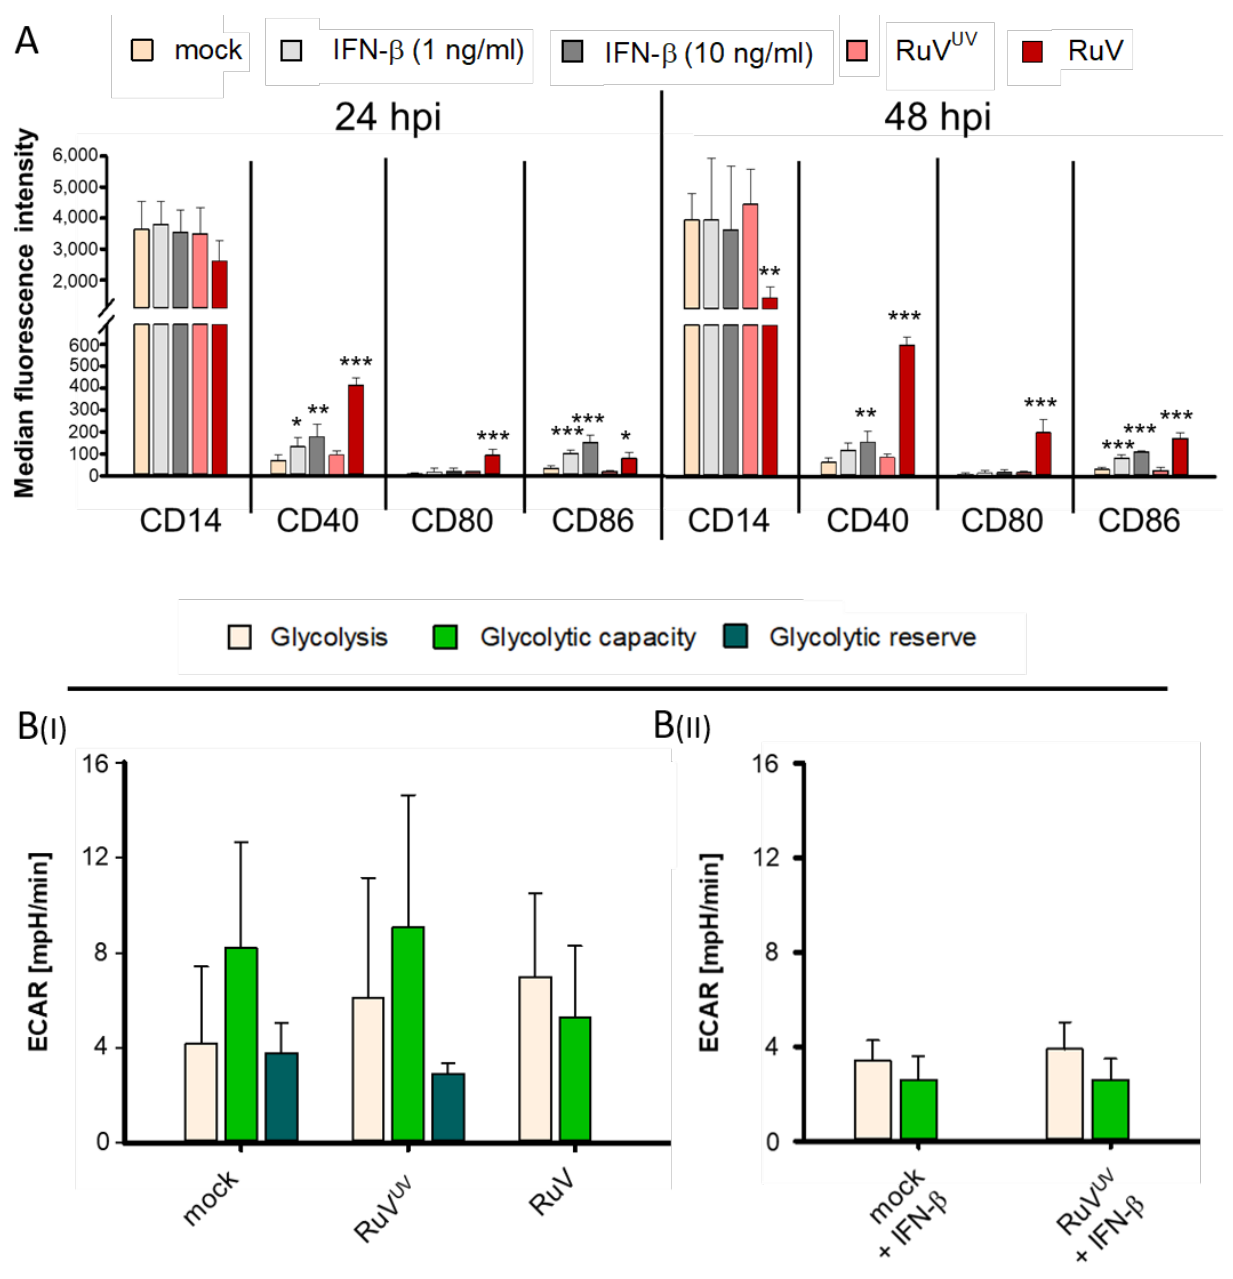
Figure 3. During RuV infection and in the presence of exogenous IFN- β glycolytic reserve was lost in M-M Φ . ( A ) Analysis of surface expression of CD14, CD40, CD80, and CD86 in mock-, RuV UV -, and RuV-infected and exogenous IFN- β treated GM- and M-M Φ by flow cytometry after indicated incubation intervals. Relative surface marker expression after application of exogenous IFN- β (10 ng/mL) for 24 h was assessed by flow cytometry with the respective antibodies. Values ( n = 3) of the isotype-corrected MFI ± SD are shown. Statistical analysis was performed using ANOVA test and significance was calculated to the respective mock control. ( B ) M-M Φ (5 × 10 5 /mL) were ( BI ) mock- infected or infected with RuV UV or RuV or ( BII ) mock- and RuV UV -infected in the presence of IFN- β (10 ng/mL). Glycolysis was measured through extracellular flux analysis as real-time ECAR by the glycolysis stress test and successive injection of glucose to measure glycolysis and of oligomycin to measure glycolytic capacity and reserve. Data are shown in bars as the mean plus standard deviation ( ± SD) and were derived from three independent experiments with two wells per sample and experiment. * p ≤ 0.05, ** p ≤ 0.01, *** p ≤ 0.001. 3.4. Blockage of CD14 Prior to RuV Infection of M- MΦs Reduces the Associated IFN Response CD14 is a surface receptor and serves as a marker during differentiation of monocytes into MΦs [37]. Antibody -mediated blockage of CD14 is a feasible approach to study its function. Blockage results directly in loss of CD14 receptor functions, such that expression of CD14 can be maintained during in vitro differentiation of monocytes [21]. Thus, we addressed the role of CD14 during RuV infection through the application of blocking an- tibodies to M- MΦs, as CD14 was significantly reduced on this MΦ subtype after RuV in- fection (Figure 2). As expected, Western blot analysis reflects a significant reduction in CD14 through blocking antibodies in comparison to the isotype control (Figure 4A(I,II)).